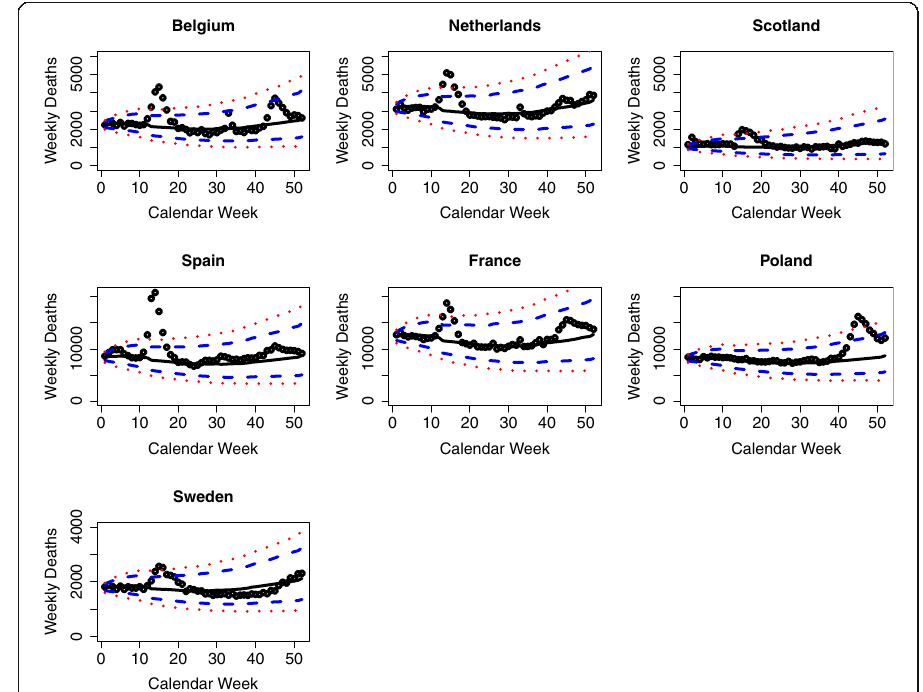
Fig. 7 Observed and predicted weekly deaths in 2020 by country for countries with statistically significant excess mortality. Sources: Human Mortality Database (2021); Computations and design by the